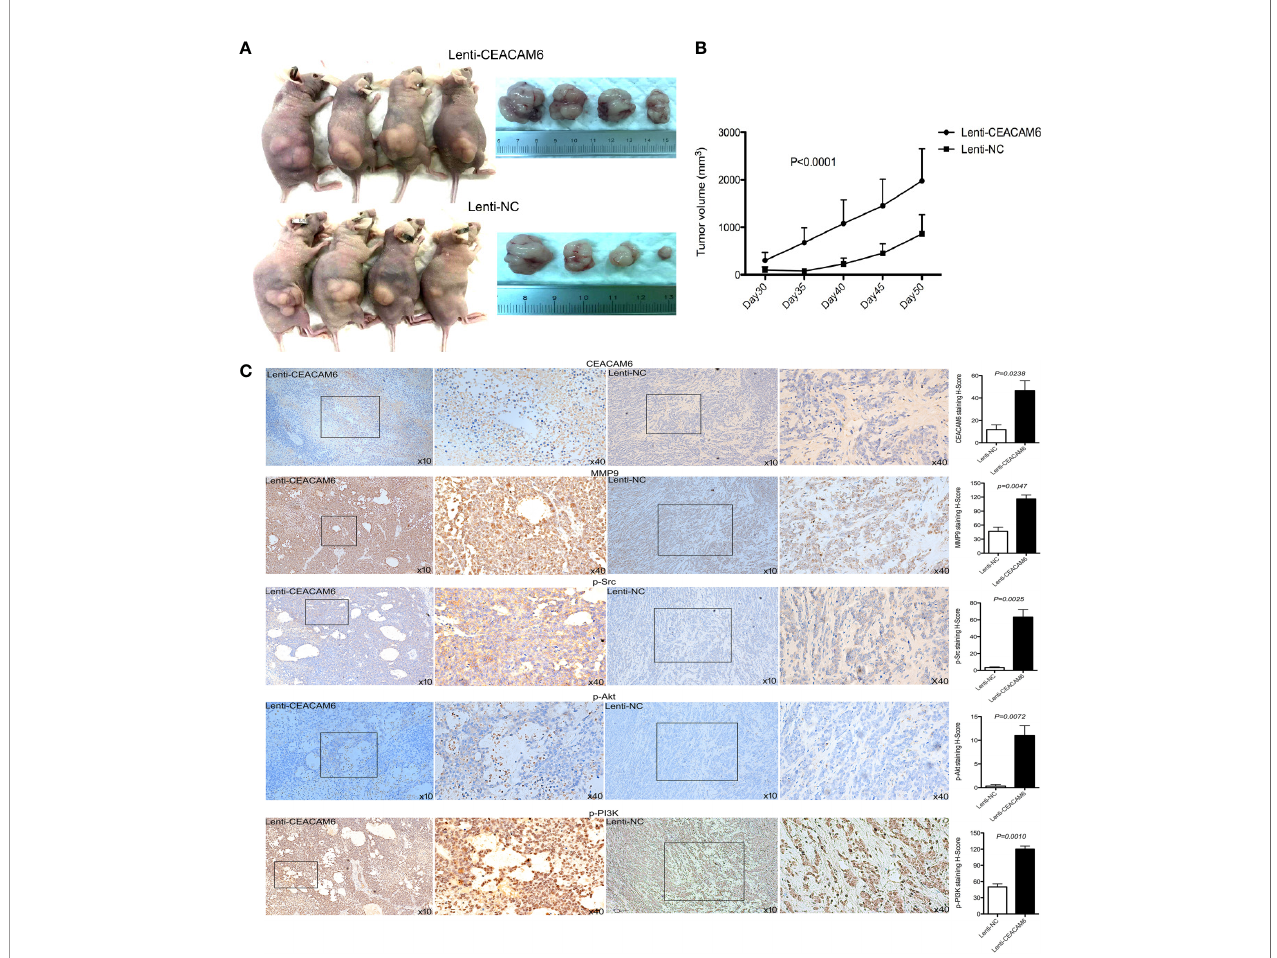
FIGURE 4 | The effect of CEACAM6 on cell derived tumorigenesis. (A) Approximately 4 × 10 7 MKN-45 cells infected with Lenti-CEACAM6 or Lenti-NC were inoculated subcutaneously into the mice, the MKN-45 cell derived subcutaneous tumors in a xenograft mouse model was constructed. (B) 30 days after the inoculation, the width and length of tumor were measured and the volume was calculated in vivo every 5 days till day 50. (C) At the day 50, the mice were euthanasia, the subcutaneous tumors were harvested for IHC staining of p − Akt, p − PI3K p − Src, and MMP9. The images in the left panel were magni fi ed 100 folds (x10), and images in the right panel are a magni fi cation of the indicated black boxes, at 400 folds magni fi cation (x40), the positive staining was showed in the brown. All IHC sections were scanned by 3D HISTECH (pannoramic MIDI) and 10 randomly selected fi elds were checked under pannoramic viewer, the percentage of positive cells was analyzed by the densito quant software and the staining H-Score was calculated and showed with histograms (right panel). The data are expressed as the mean (± SEM) of staining H-Score from three independent